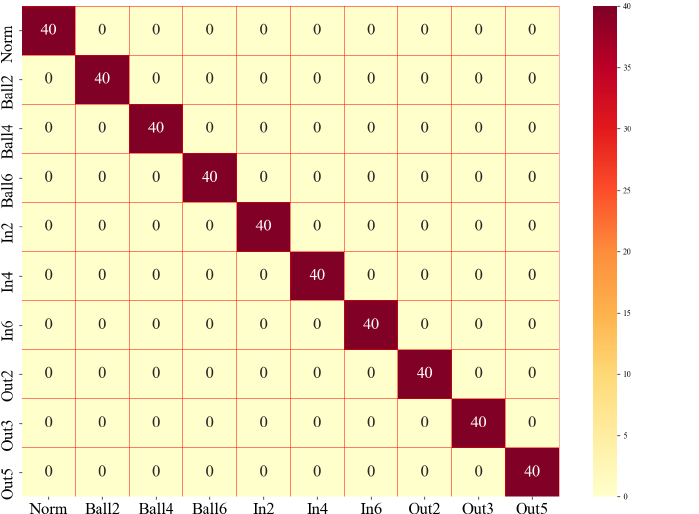
Figure 12. Multi-class confusion matrix of proposed method on DUT dataset.